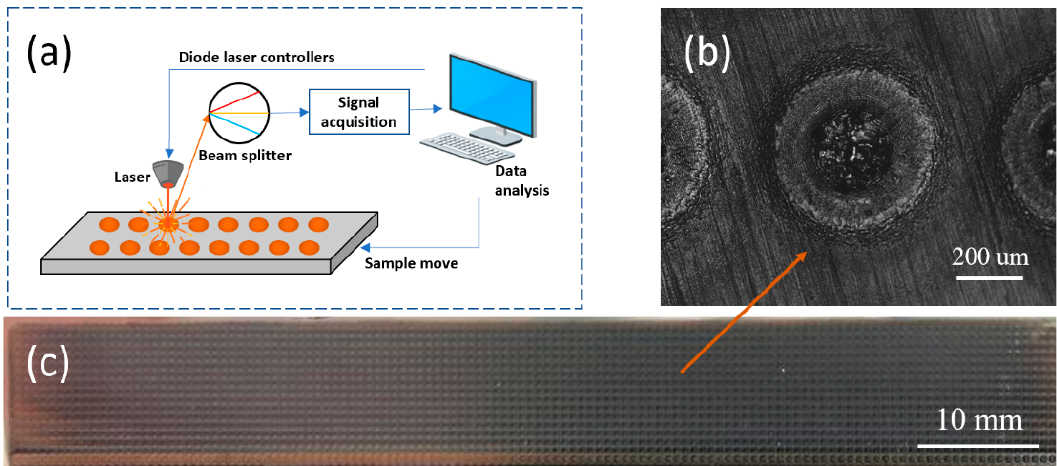
Figure 4. Schematic diagram of a laser-induced breakdown spectroscope (LIBS) and the surface topography of a sample after testing: ( a ) the principle of LIBS; ( b ) the morphology of a single point after laser excitation on the surface; ( c ) the morphology of a sample after laser excitation.